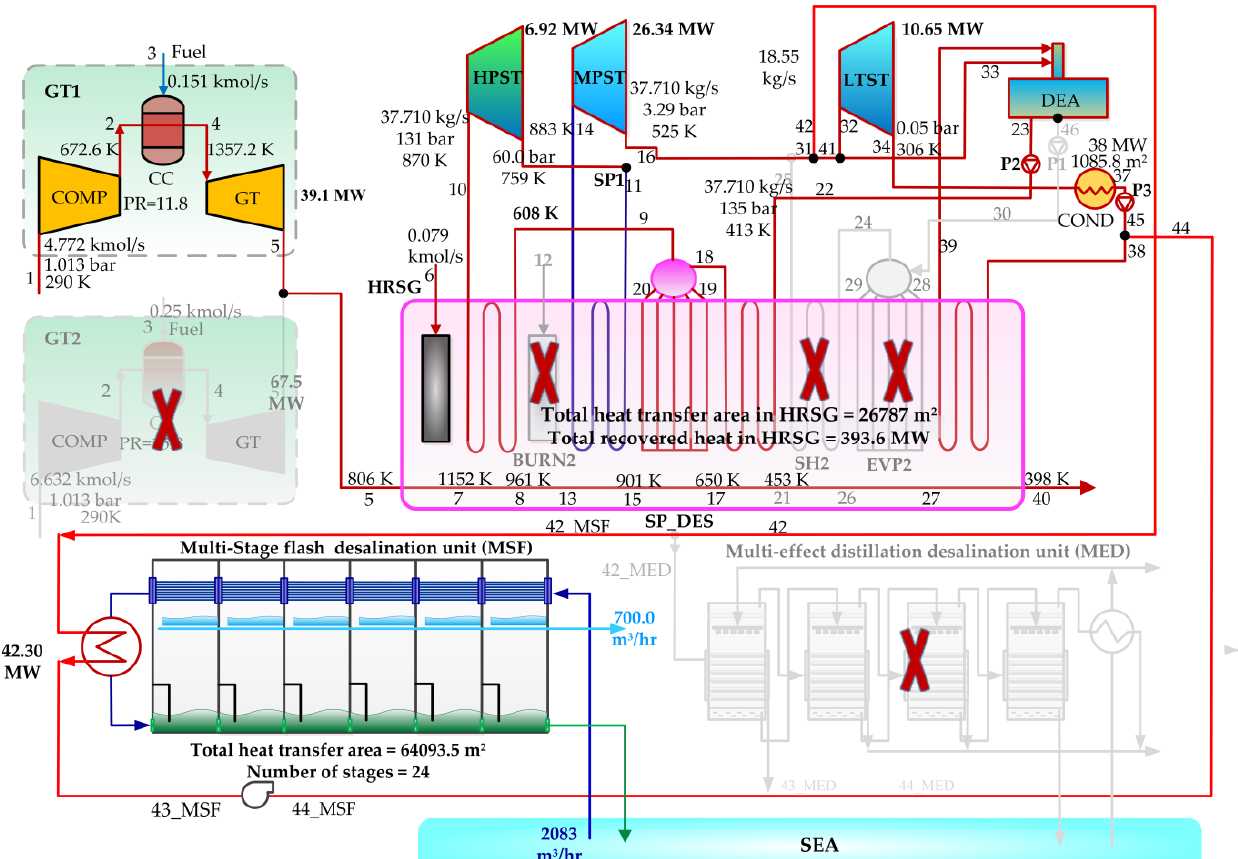
Figure 5. Optimal configuration of the integrated power/desalination process obtained by minimiz- ing the total annual cost to generate 80.0 MW of net electrical power and 700 m 3 /h of freshwater. Several optimization problems were solved for the same design specifications, process data, and cost model with the aim of obtaining suboptimal solutions for investigating how much better the optimal configuration presented above is with respect to other con- figurations. To achieve it, different process configurations were fixed by properly setting the values of the discrete decisions. The main results are compared in Table 3. Figure 6 illustrates a sub-optimal solution obtained by considering GT2 instead of GT1 and keeping the MSF unit but including BURN1 and BURN2. Table 3. Comparison of the costs obtained by the optimal and suboptimal configurations.